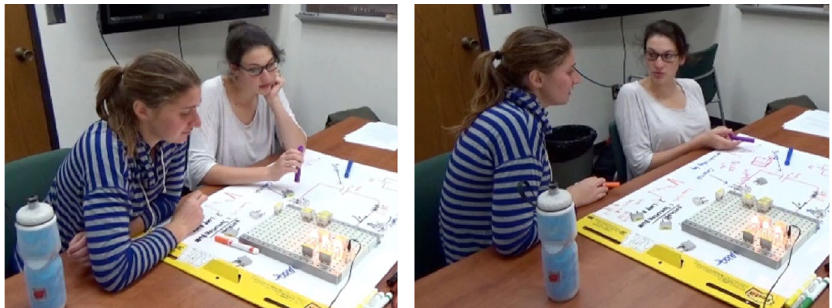
FIG. 2. Student body position and gaze before (left) and after (right) the frame